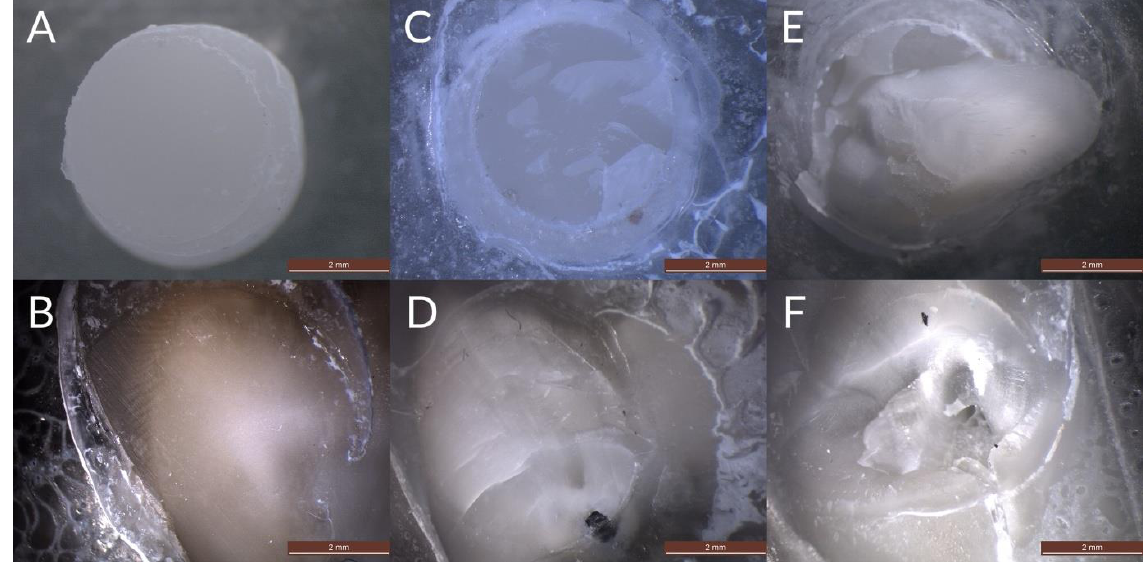
Figure 5: Representative images of failure mode of ceramic surface (CS) (ACE) and dentin surface (DS) (BDF) in group MBEP (A,B) Adhesive; (C,D) Cohesive; (E,F)